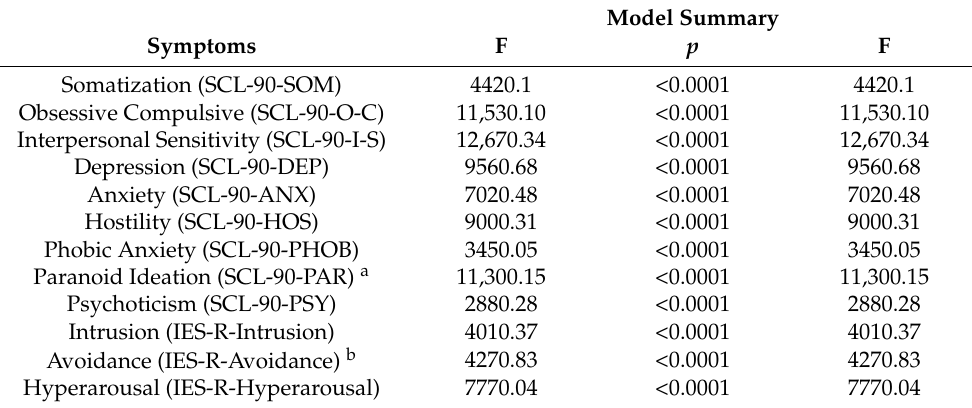
Table 5. Multivariate linear regressions for mindfulness and defense mechanisms predicting psychi- atric symptoms (N = 6385).